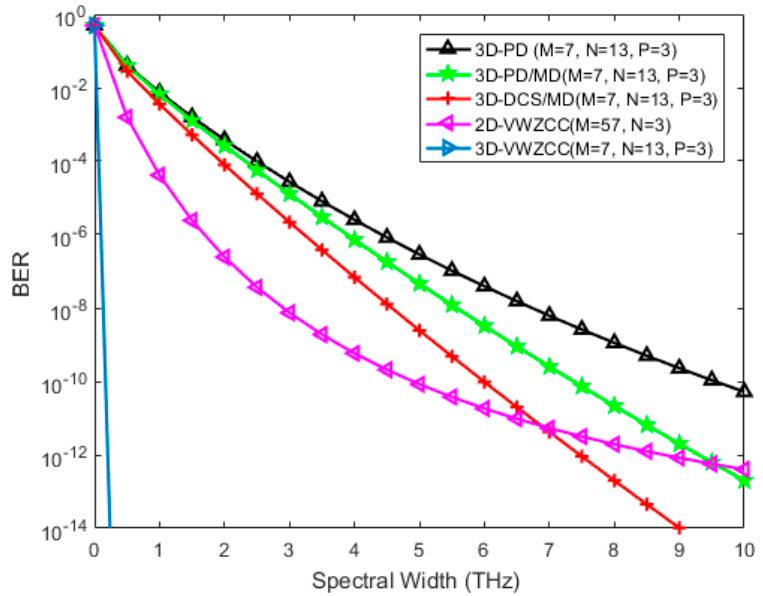
Figure 5. BER versus spectral width when the number of active users K = 150 and data rate R b = 1